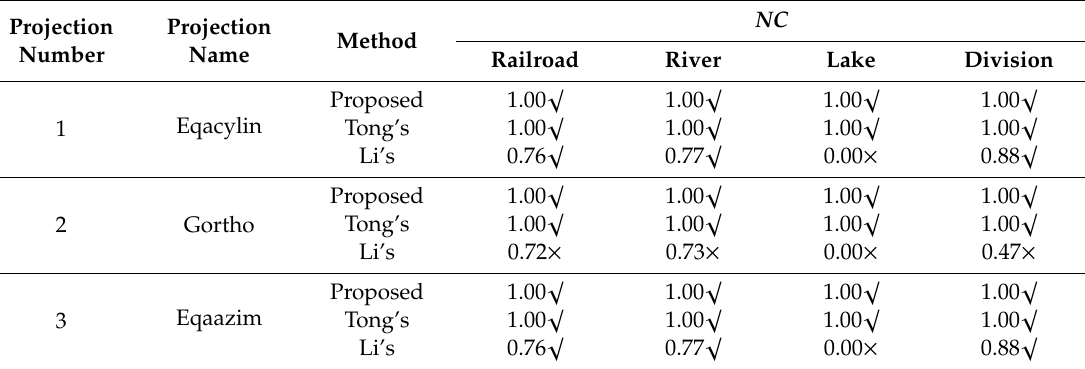
Table 5. The results after equal area projection